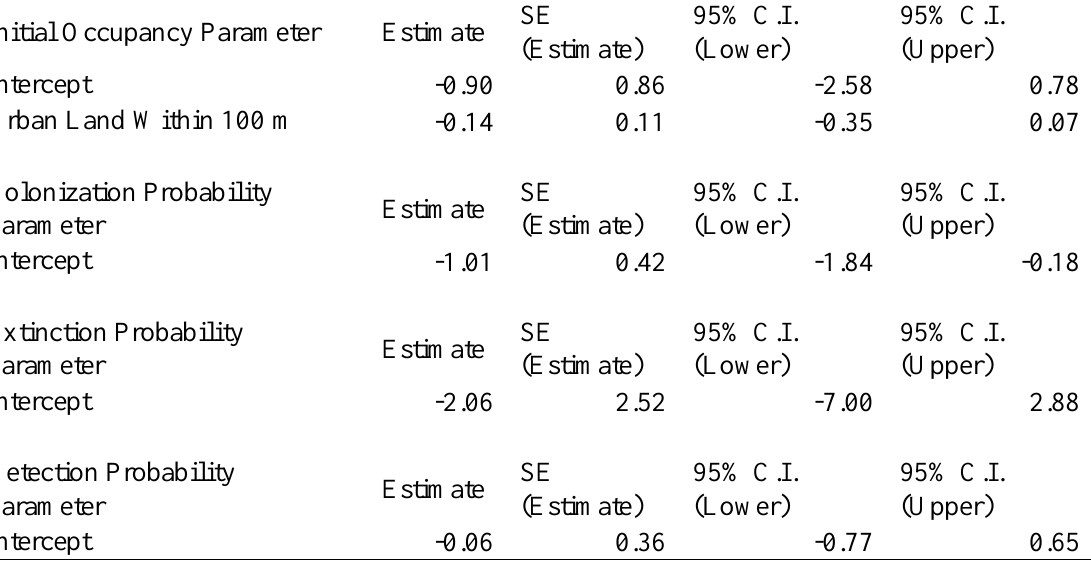
Table A3.C. Second-highest-ranking multi-season occupancy model (AIC ∆ AIC =2.13, AIC weight=0.10) for Le Conte’s Sparrows along 47 transmission line study sites c in Winnipeg, Manitoba, Canada in 2008-2009 (n=276 surveys), assuming no effect of mowing on probability of colonization or extinction, and no effects of Julian date, time of morning or observer experience on probability of detection given presence at sites.